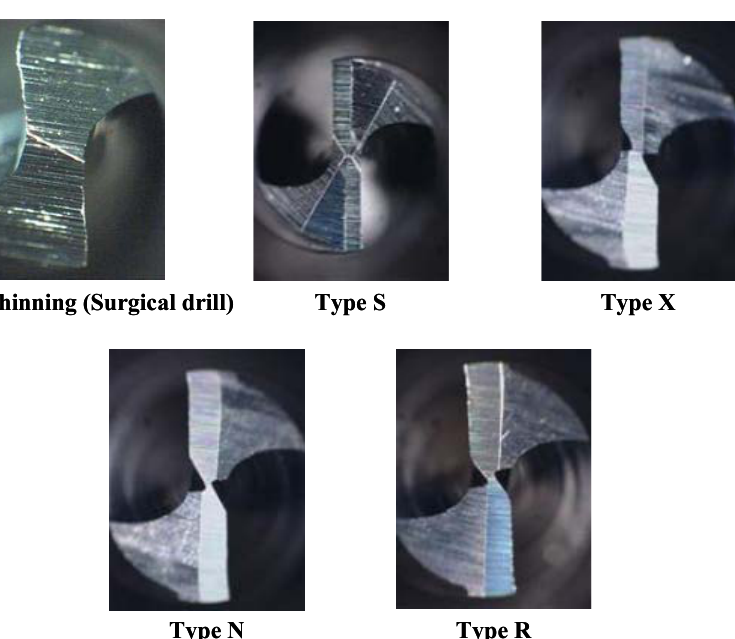
Without thinning (Surgical